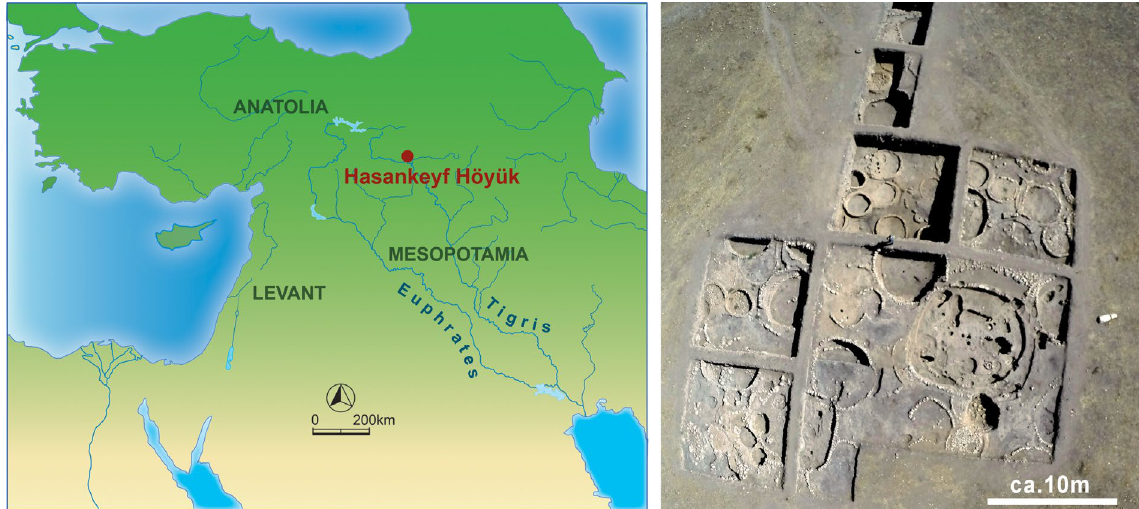
Figure 1. Location of Hasankeyf Höyük and an aerial view of the excavated